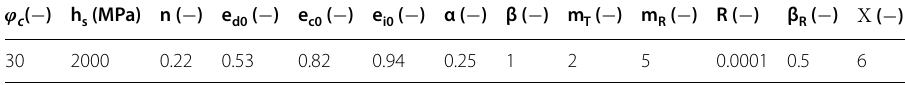
sand. A time scaling factor (which determines the number of time steps in ABAQUS) of 0.4 was chosen after multiple iterations in order to ensure convergence.